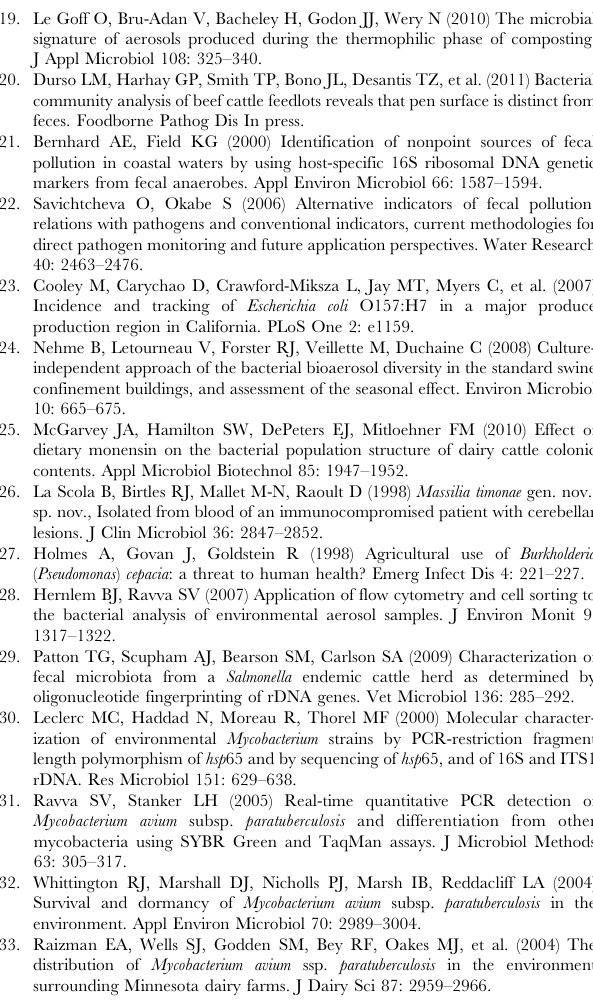
Figure S1 Comparison of OTU libraries from aerosols with libraries generated from fresh and dry manure samples collected from Sonoma and Modesto dairies using RDP Library Compare. OTU libraries generated from aerosols from both dairies were also